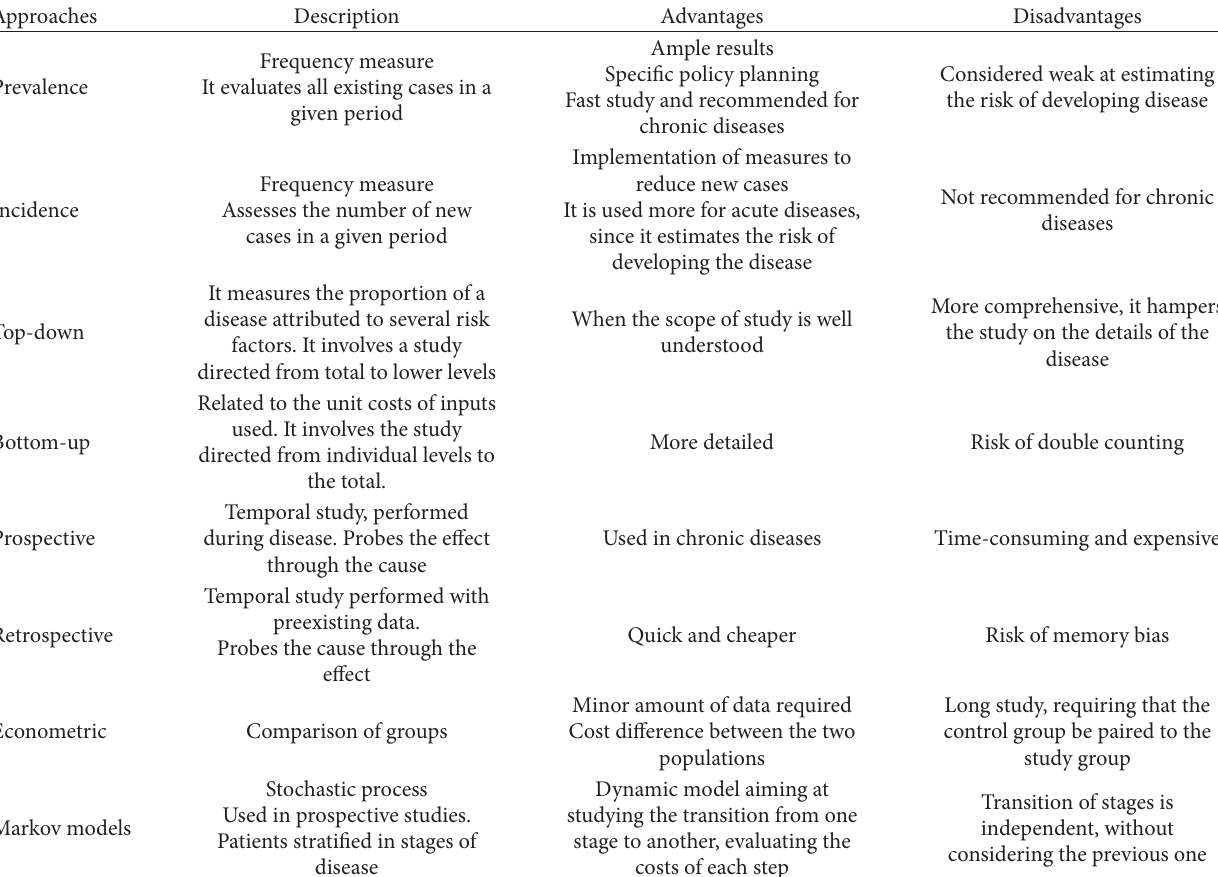
Table 2: Main study designs on